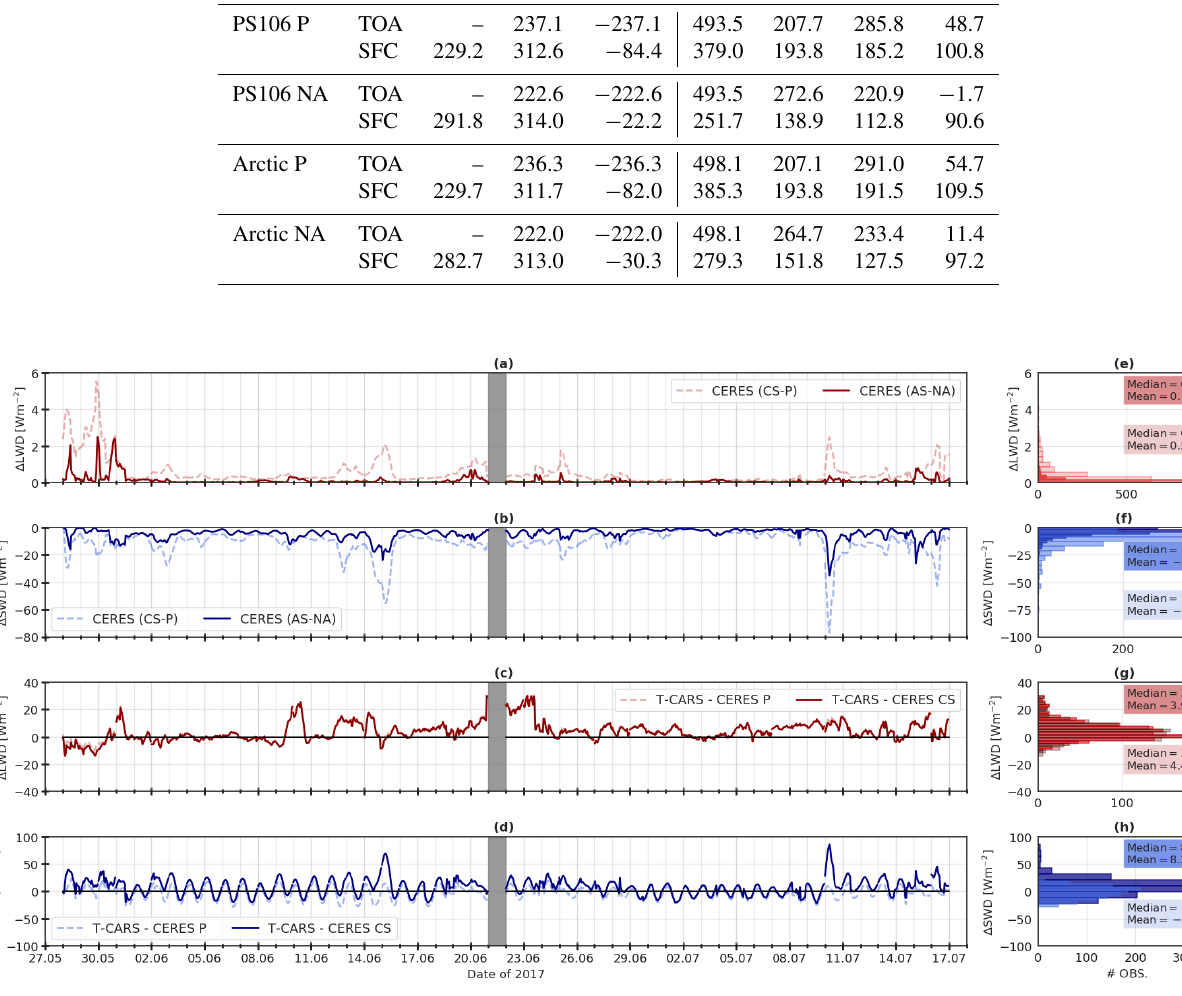
Figure B1. Time series of the difference of downward surface radiative fluxes between CERES SYN1deg and T-CARS for pristine ( P ), clear-sky (CS), all-sky (AS), and cloudy without aerosols (NA) conditions. Panel (a) shows the difference of the downward LW (LWD) CERES SYN1deg (CS-P) and CERES SYN1deg (AS-NA). Panel (b) shows the same as (a) , but the downward SW (SWD) flux. Panel (c) shows the LWD differences between T-CARS and CERES SYN1deg P , and T-CARS minus CERES SYN1deg CS. The histograms of each left-hand side panel are shown on the right. The LWD and SWD fluxes are shown in red and blue,